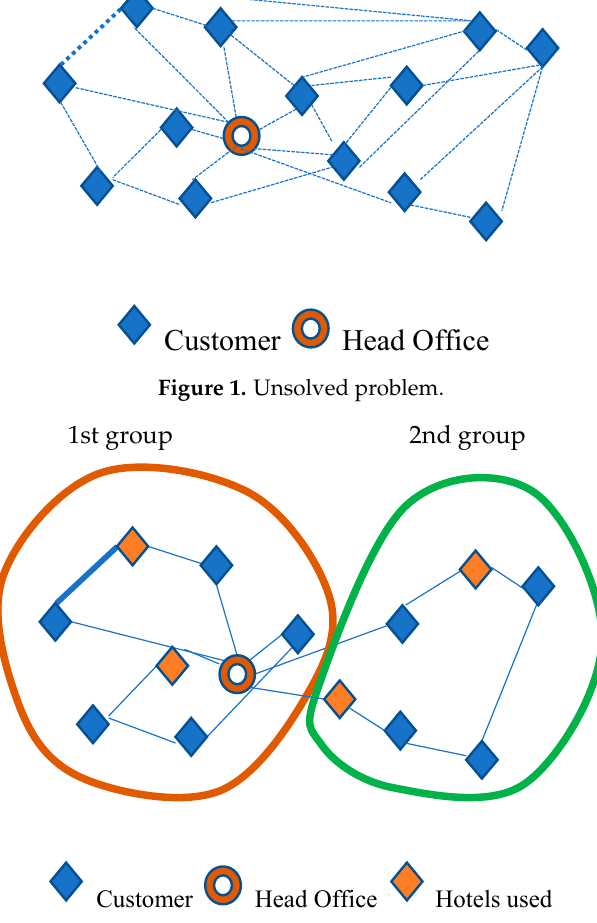
Figure 2. Solved problem. Figure 2. Solved